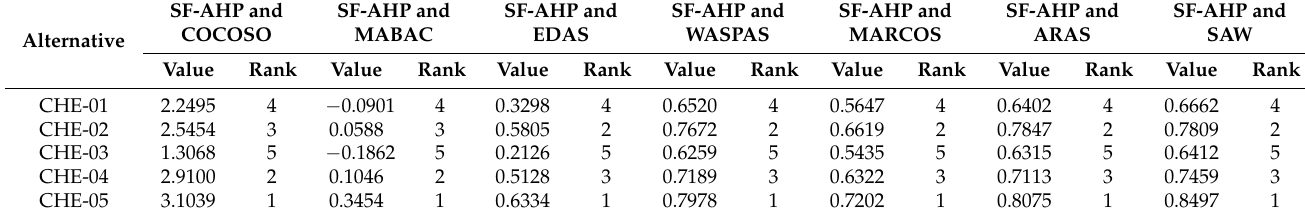
Table 14. Results of the comparison analysis of methods.